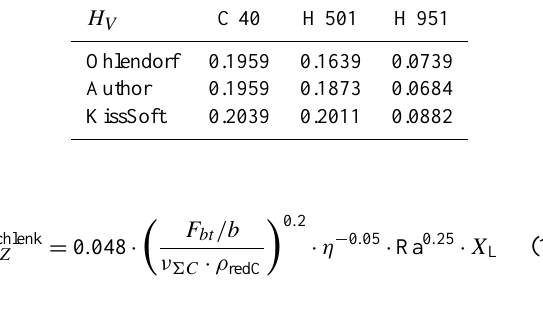
Figure 3. Torque loss for different gear geometries lubricated with a mineral wind turbine gear oil (Fernandes et al., 2015).